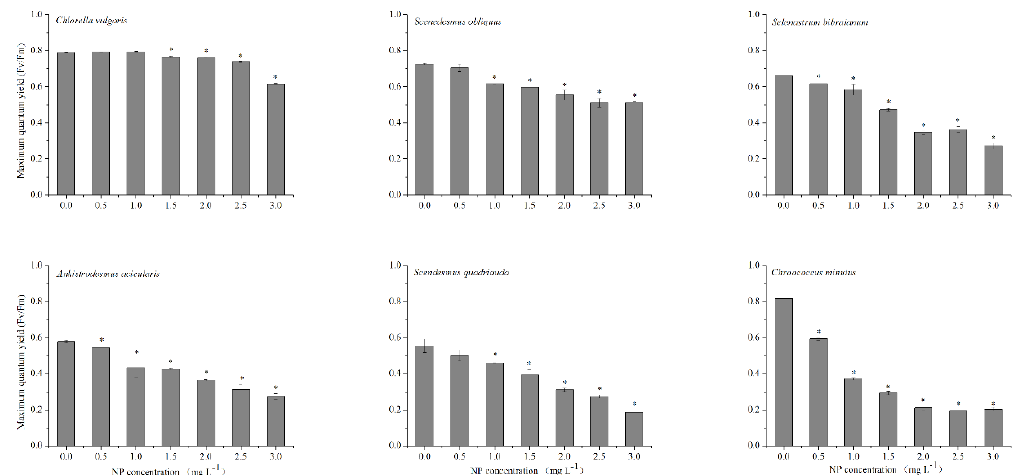
Figure 2. Effect of NP on the maximal PSII activity ( Fv/Fm ) in microalgae. Algae were treated with NP at 0–3.0 mg L −1 culture for 96 h. Mean and standard deviation of three replicates are shown. Values are the mean ± standard deviation (SD) ( n = 3). Asterisks indicate the significant differences between the NP treatments and control ( p < 0.05).